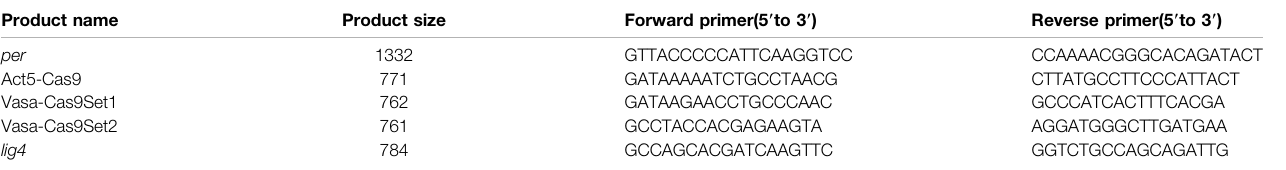
TABLE 3 | Molecular screening for per